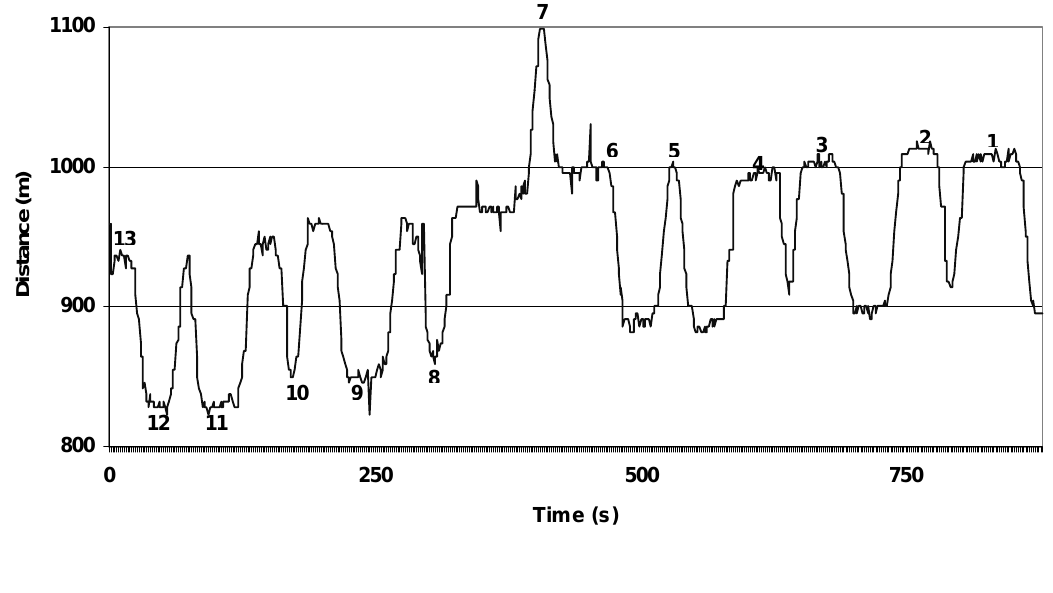
Figure 7. Distance between two successive trains running on the VAL line versus